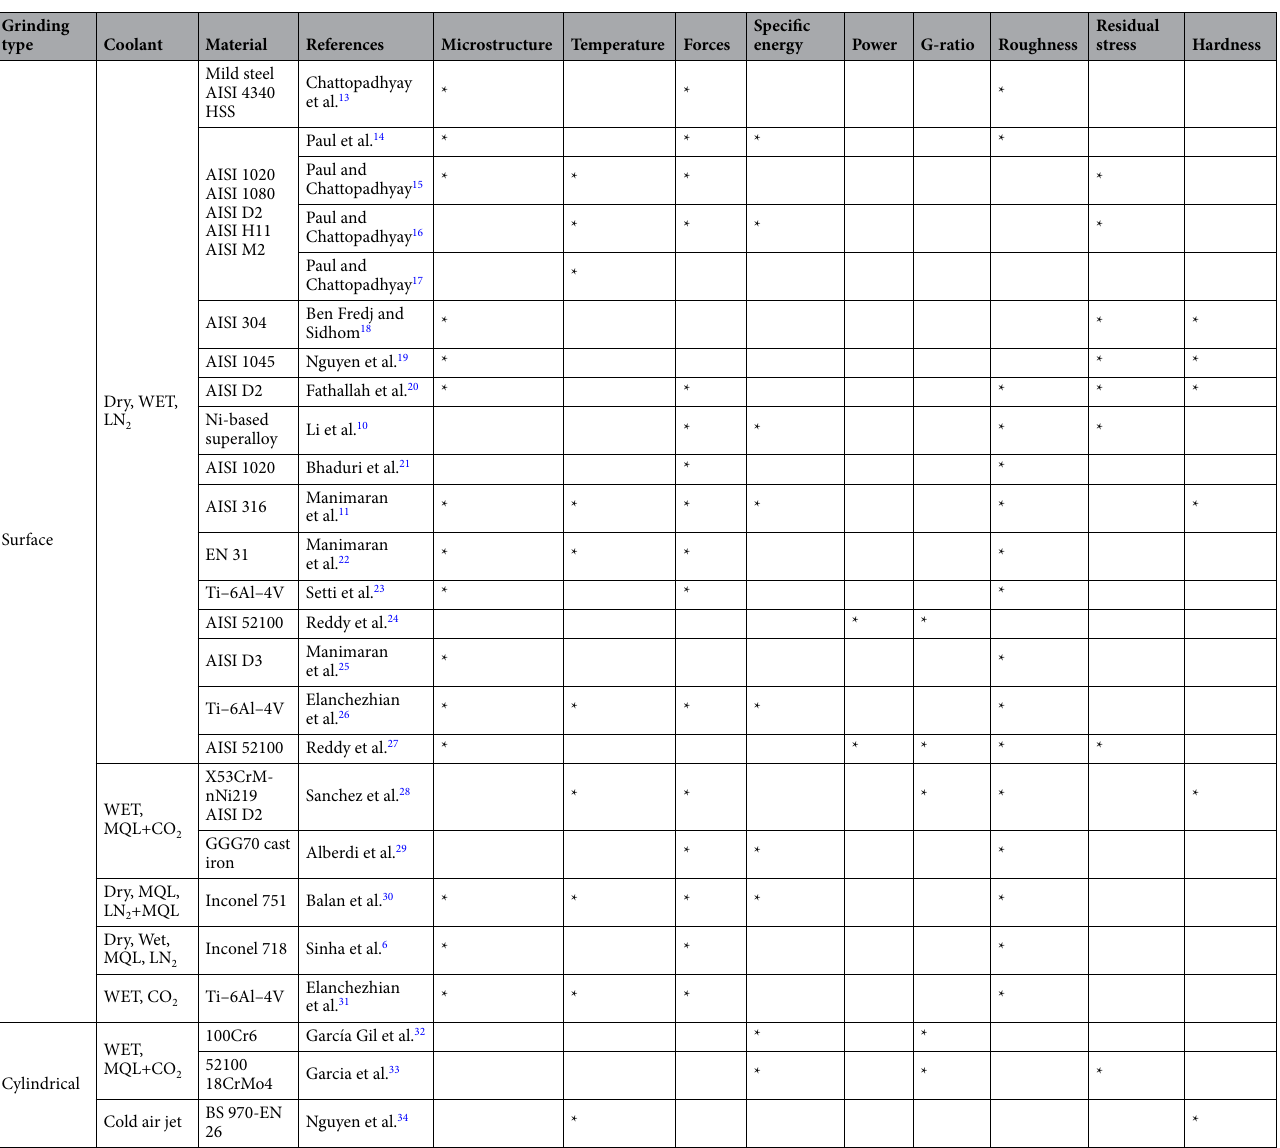
Table 1. Literature review in cryogenic grinding